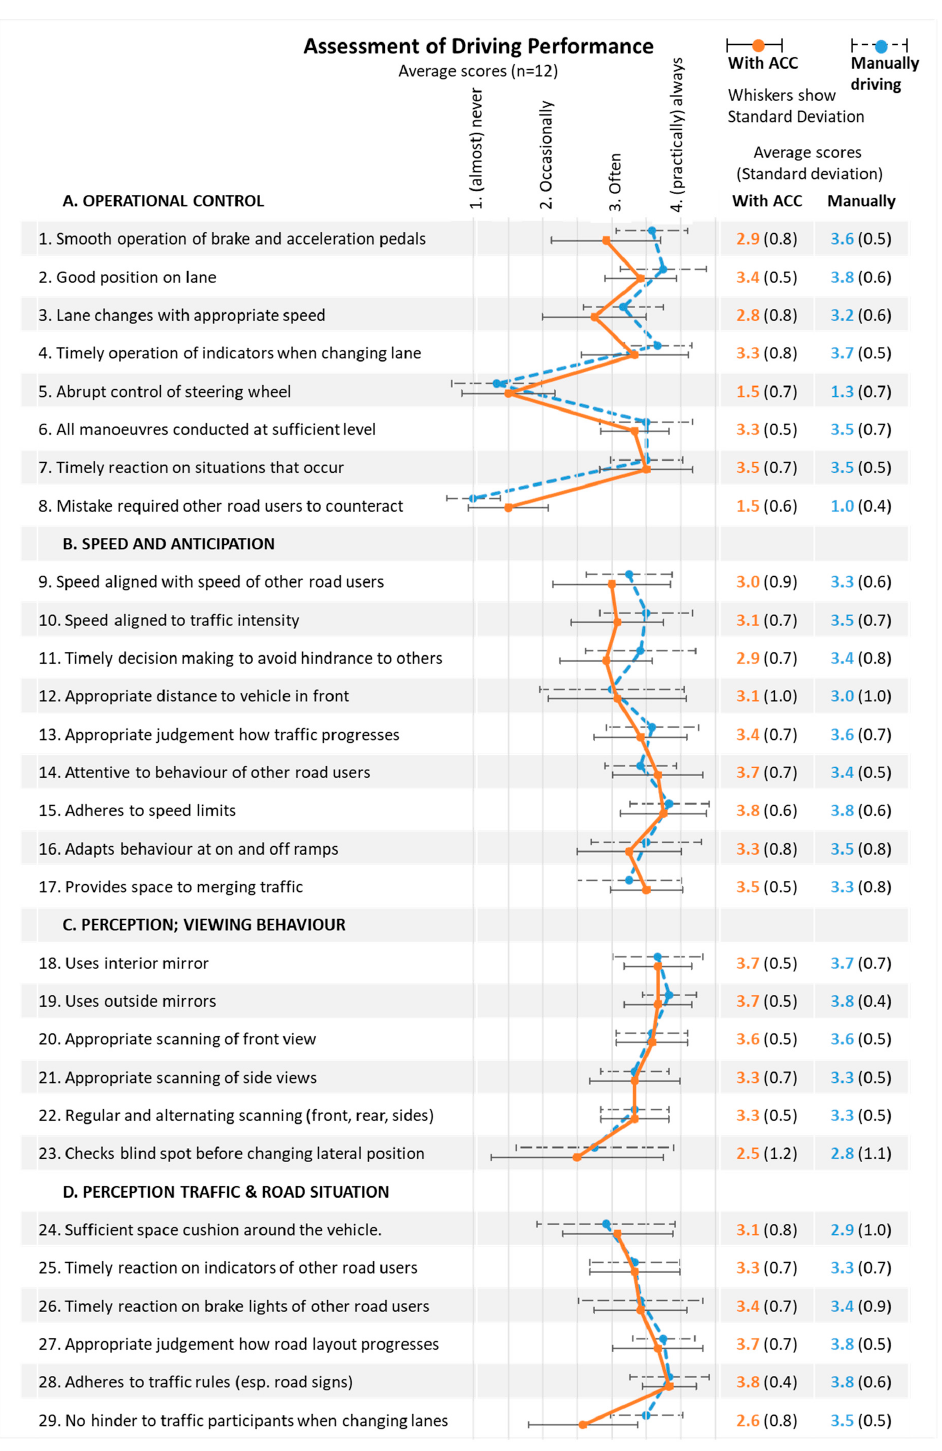
Figure 3. Overall expert-assessment of driving performance using D-Brief for driving manually vs. with ACC. Except for aspects 5 (“Abrupt control of steering wheel”) and 8 (“Mistake required other road users to counteract”), all aspects are formulated as statements for favourable and ‘good’ behaviour. While the majority of scores indicated that the behaviour was observed either “often” (score 3) or “(practically) always” (score 4), the scores generally show that performance was rather good. The unfavourable (‘bad’) behaviour of aspects 5 and 8 was only rarely